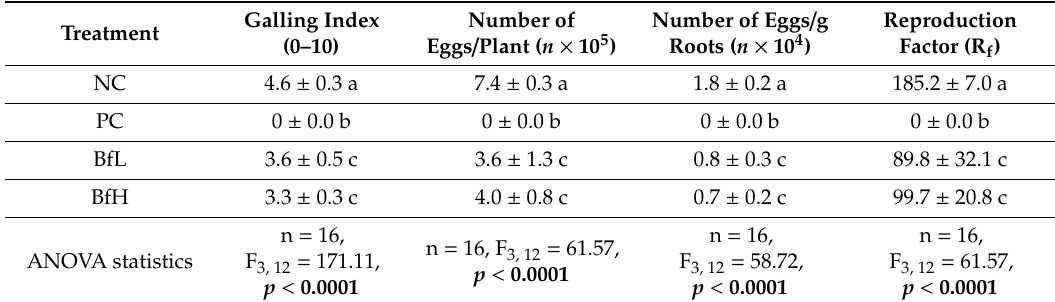
Table 1. Evaluation of Meloidogyne luci infestation in tomatoes in the pot experiment.